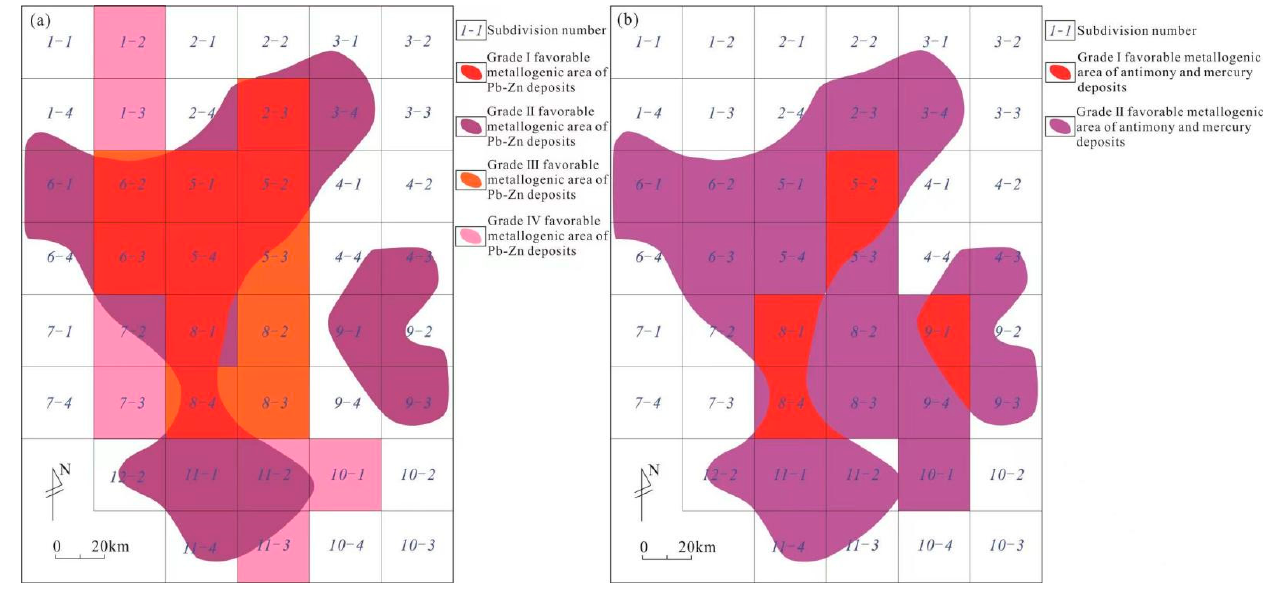
Figure 14. Distribution map of comprehensive favorable metallogenic areas. ( a ) Distribution map of Pb–Zn deposits comprehensive favorable metallogenic areas and ( b ) Distribution map of Sb–Hg deposits comprehensive favorable metallogenic areas.